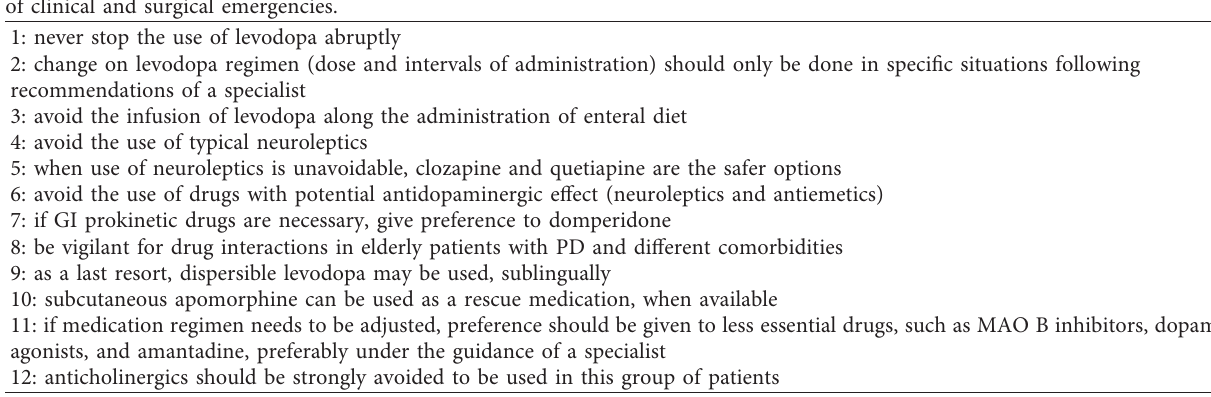
Table 3: Basic recommendations for health care of physicians involved in the management of patients with advanced PD during evaluation of clinical and surgical